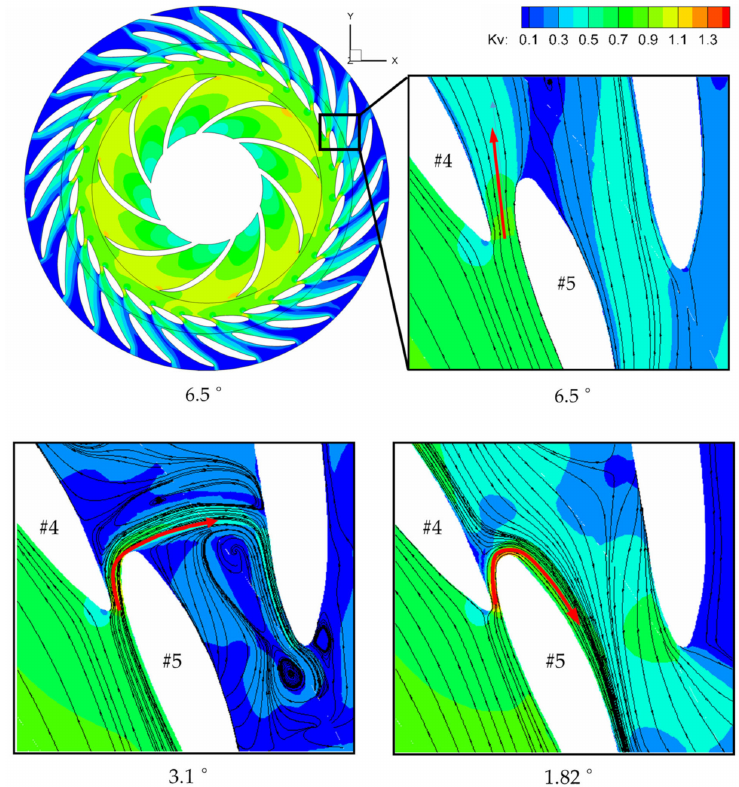
Figure 7. Global velocity contours of the shutdown process (Z = 0 plane).